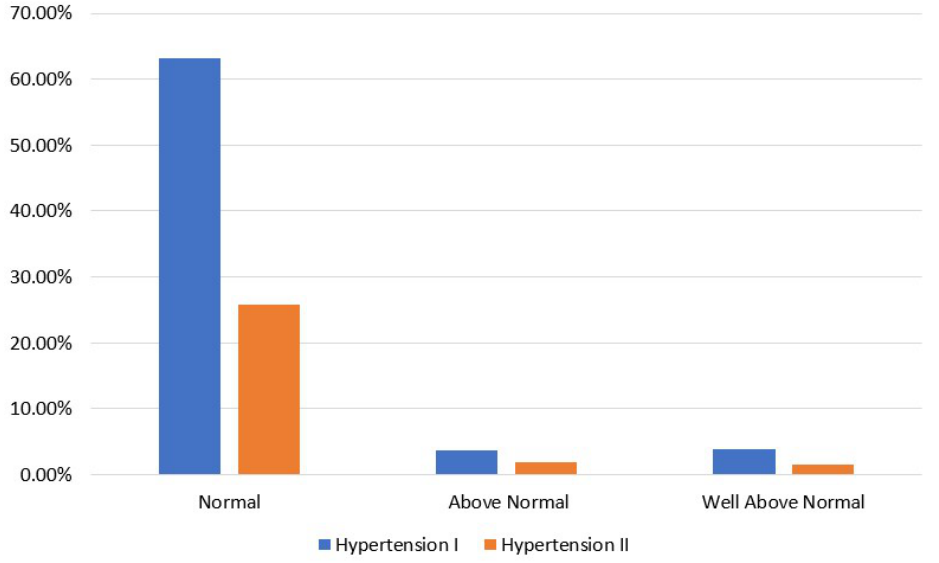
Figure 3. CVD participants’ distribution in terms of glucose level and hypertension classes in the balanced